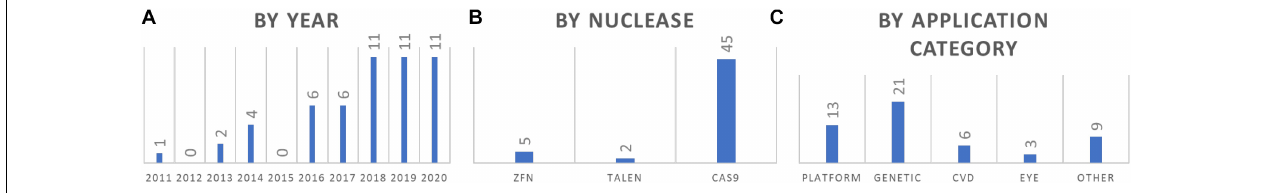
Frontiers in Genetics |